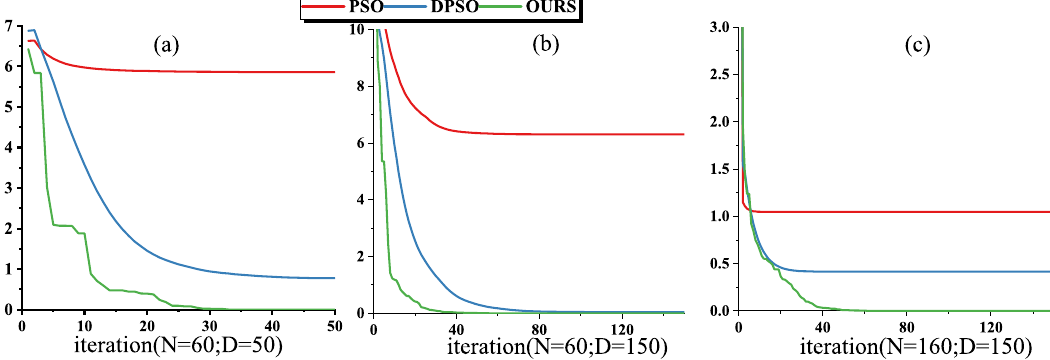
Figure 4. Convergence curves of three algorithms under different combinations of particle swarm size and iteration number, N denotes the particle swarm size and D denotes the maximum number of iterations, the red, blue and green lines represent the convergence curves of the classical PSO, DPSO and our introduced algorithm,